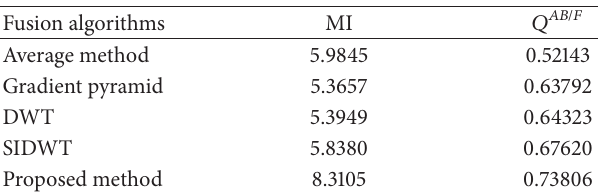
Table 3: Performance comparison of different fusion algorithms in Figure